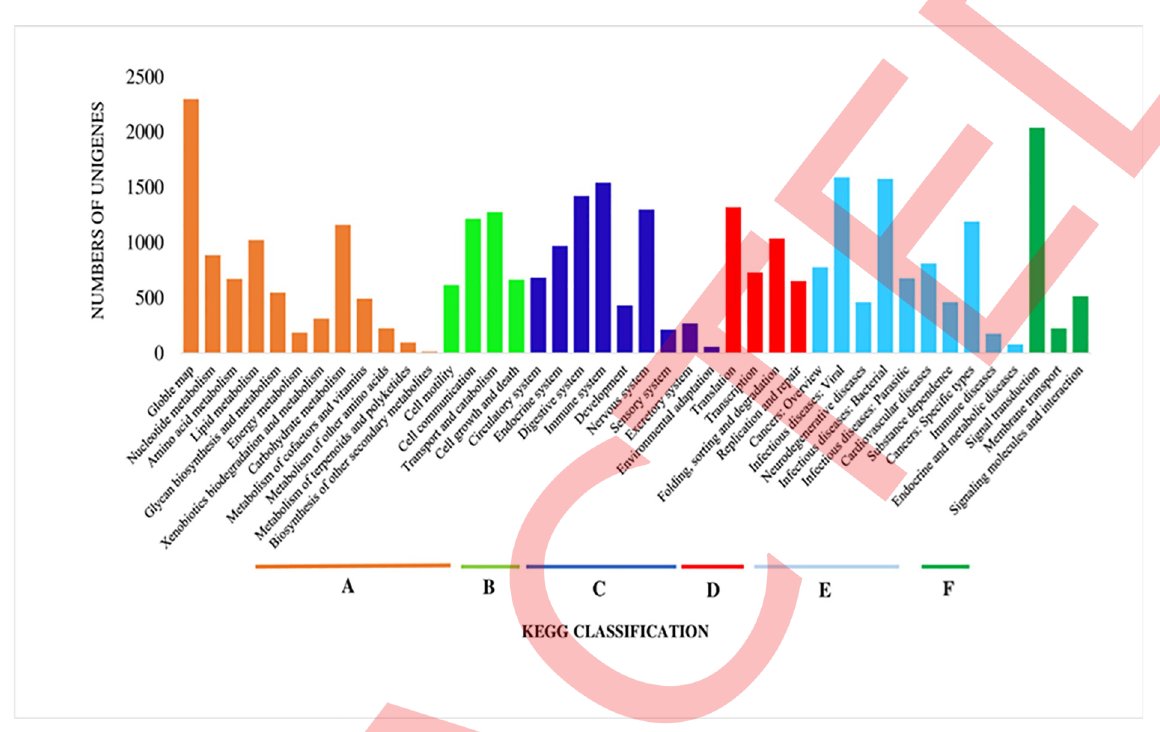
Fig 9. Kyoto Encyclopedia of Genes and Genomes pathway annotation of the Rhynchophorus ferrugineus fat body tissues transcriptome. Genes related to (A) metabolism, (B) cellular processes, (C) organismal systems, (D) genetic information processing, (E) diseases, and (F) environmental information processing were